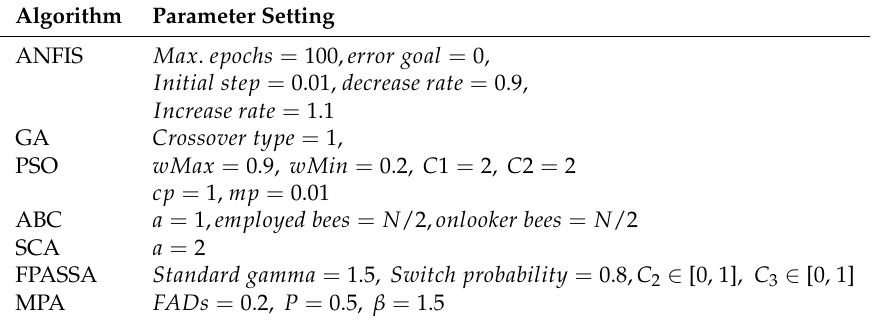
Table 2. Parameter settings. FADs, fish aggregating devices. cp , crossover probability. mp mutation probability.